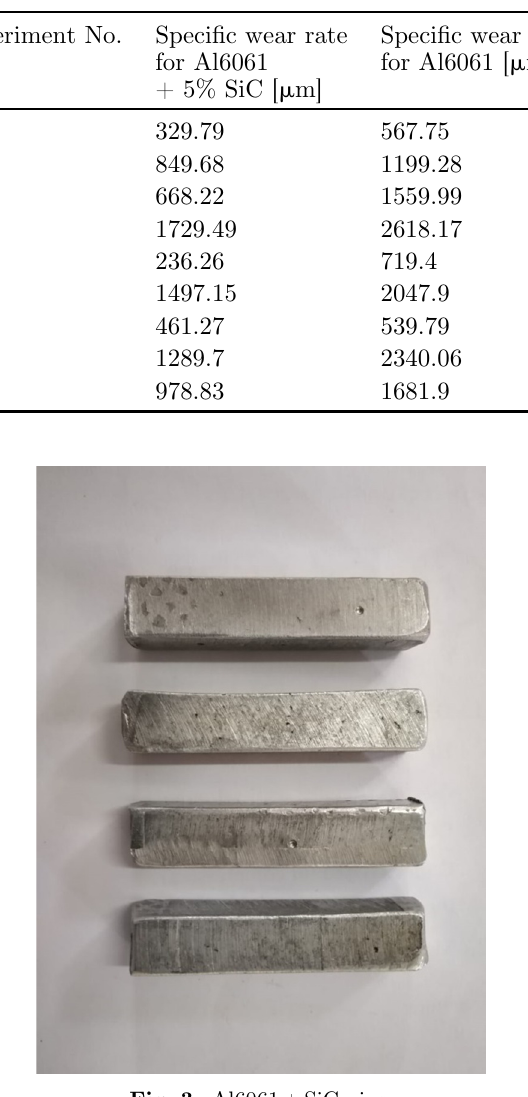
Fig. 3. Al6061+ SiC pins.